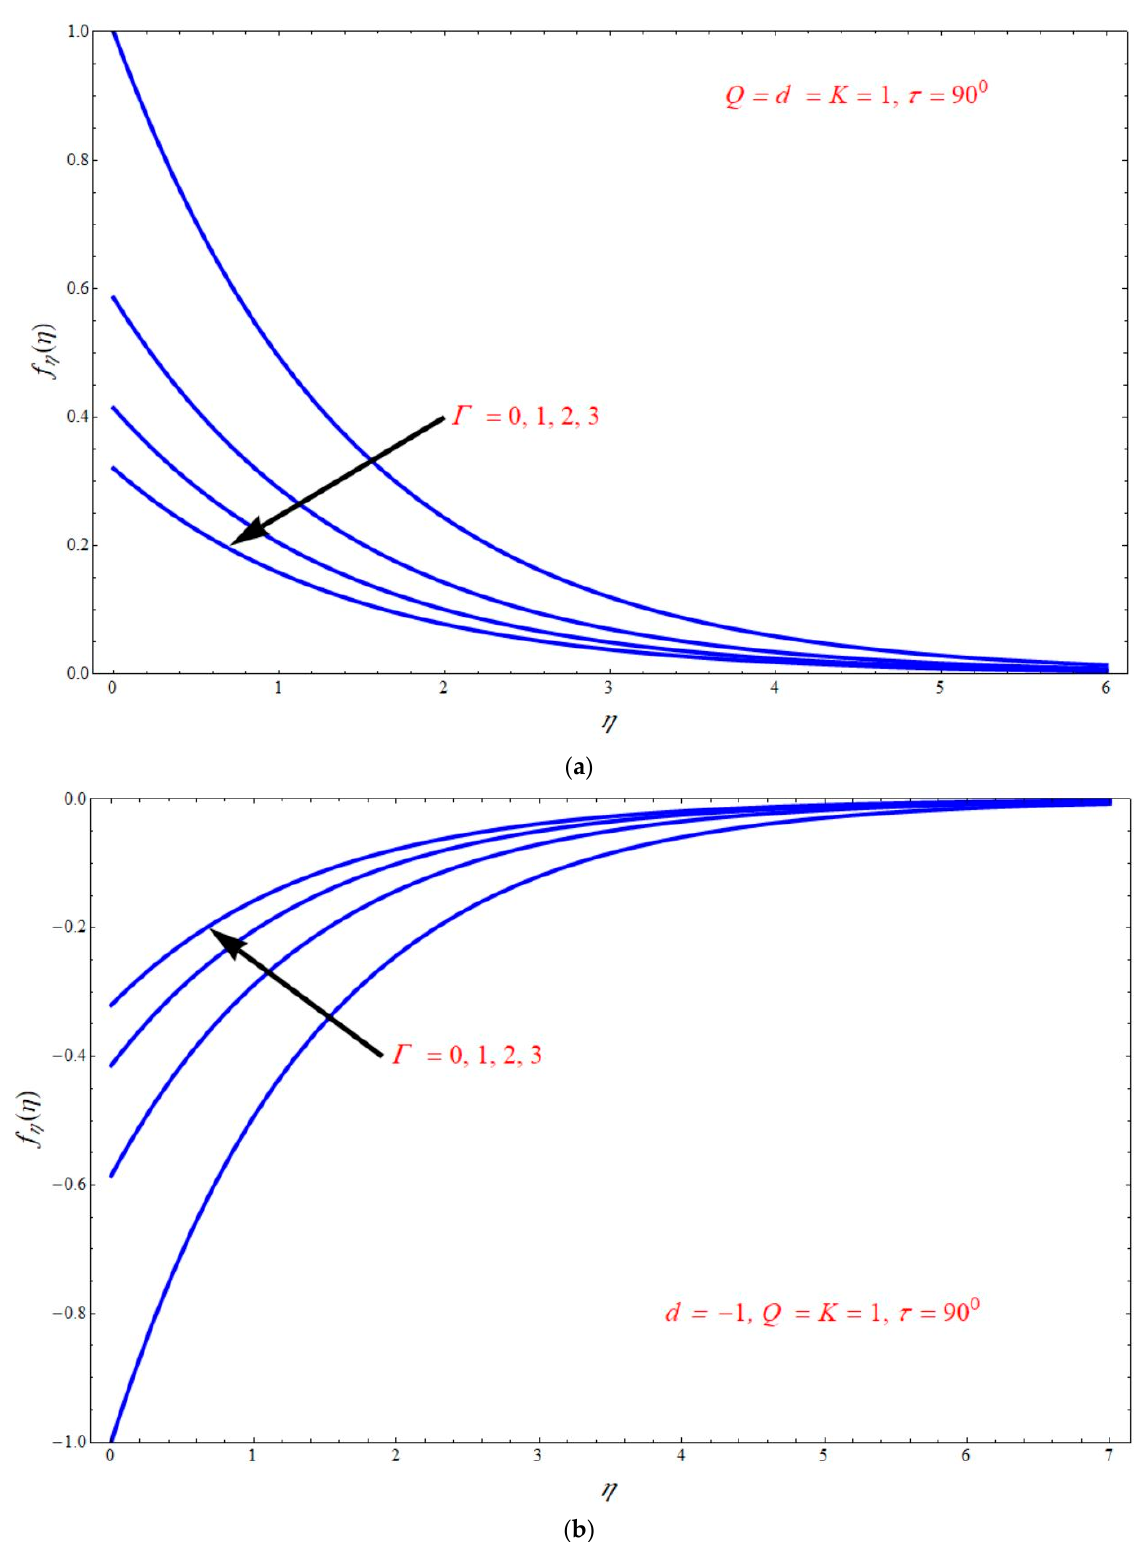
( ) η η f verses for different values of η